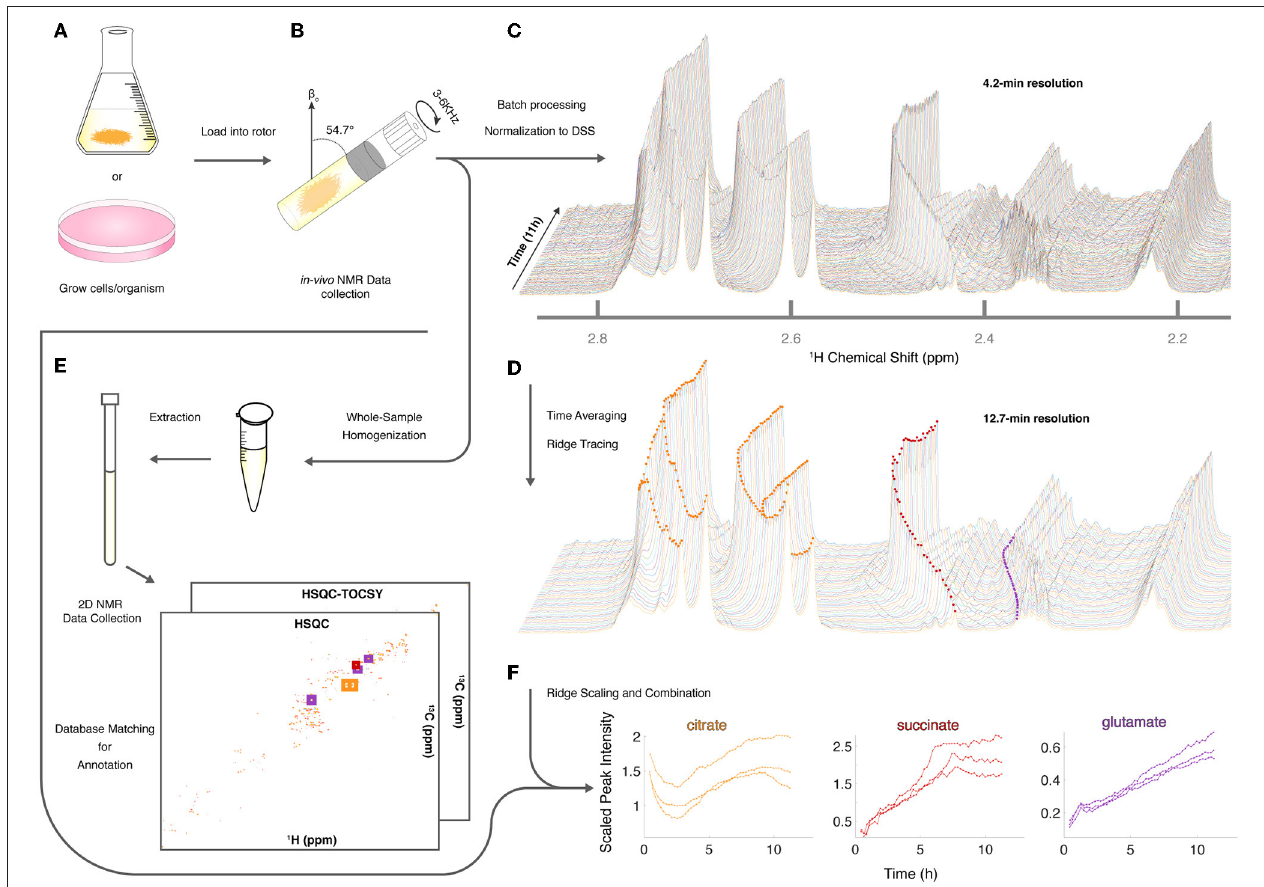
FIGURE 2 | Sample preparation and analysis for CIVM-NMR experiments. (A) Samples were first grown to a suitable volume or density in standard media and (B) transferred to the HR-MAS rotor ( N. crassa is shown). Gas composition (e.g., air availability) was altered using a filtered hole or no hole in the cap, and the rotor was spun at the magic angle. NMR data were collected continuously every 4min over the course of hours, then (C) processed and normalized to the DSS reference peak (0 ppm) to yield full-resolution data. (D) Every three spectra were time-averaged (summed) for improved S/N, and peak intensities were traced across time using ridge tracing to yield relative quantification of metabolites. (E) Following HR-MAS, the rotor contents were homogenized, methanol-extracted, and used for 2D NMR analysis for peak annotation by database matching. (F) For annotated metabolites with > 1 peak (e.g., citrate), the quantified and annotated trajectories (ridges) for each peak were scaled and combined into a single representative trajectory. Trajectories for each annotated compound in 3 aerobic experiments are plotted to compare time series between biological